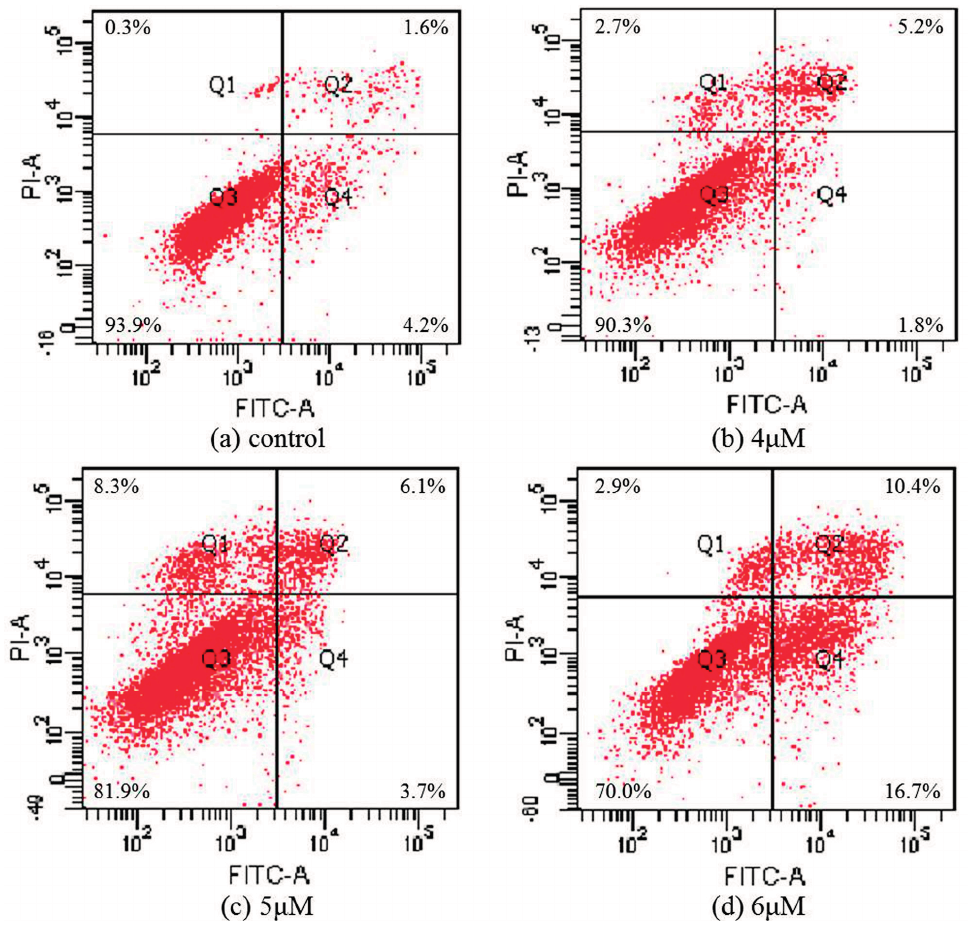
Figure 5. Apoptosis ratio detection by Annexin V/PI assay on the Bel-7402 cells treated by T-OA. ( a ) Control group without T-OA; ( b ) Treated with 5 µM T-OA; ( c ) Treated with 10 µM T-OA; ( d ) Treated with 20 µM